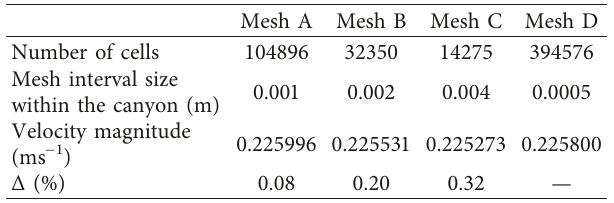
Figure 5: Mesh used for AR 1. (cid:31) Table 1: Characteristics of the four meshes used for the grid in- dependence test and corresponding percentage differences